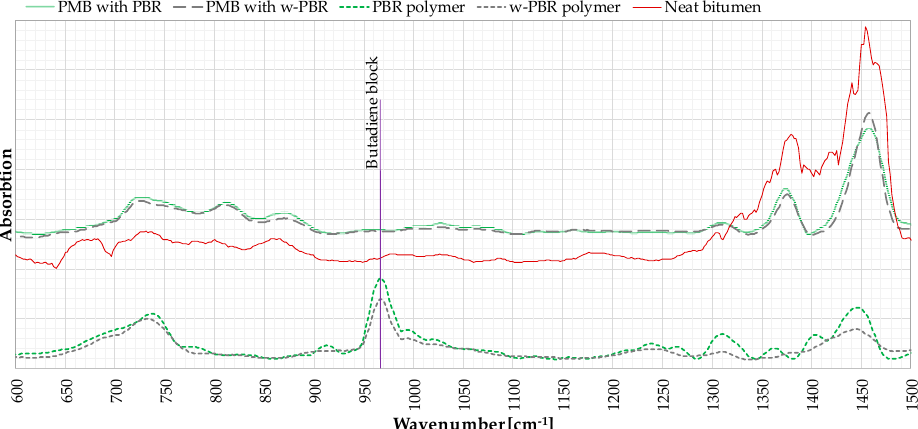
Figure 1. Results of Fourier Transform Infrared Spectroscopy (FTIR) analyses (neat bitumen, SBR and w-SBR polymers, and SBR-modified binders).